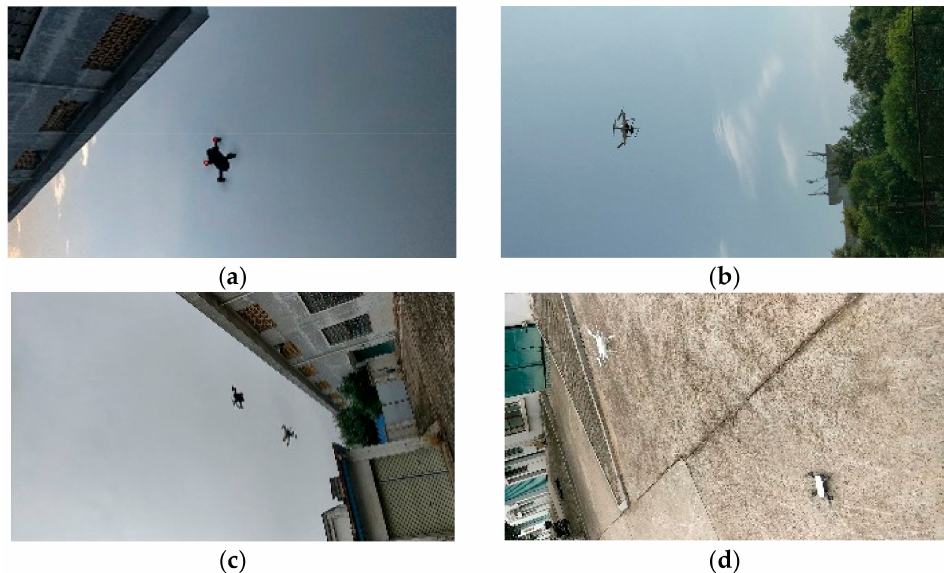
Figure 1. Examples from the UAV datasets: image ( a ) contains DJI spark; image ( b ) contains DJI phantom; images ( c , d ) contain both DJI spark and phantom.